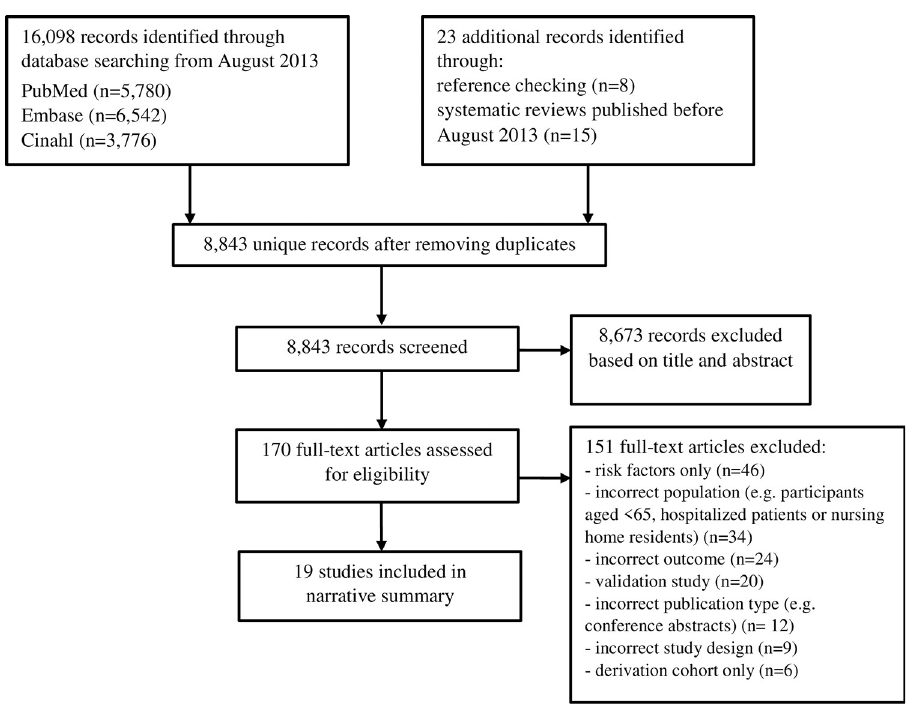
Fig 1. PRISMA flow diagram of included risk prediction